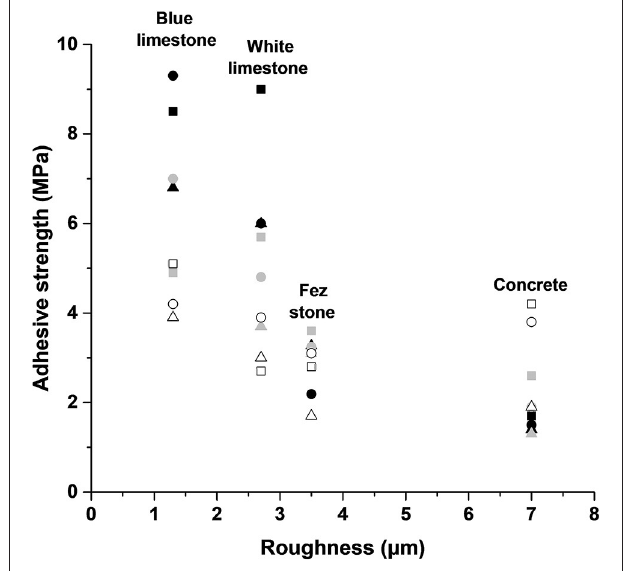
FIGURE 6 | Adhesive strength of the coatings S1M1 ( (cid:4) ), S1A3 ( N ), and S1A5 ( (cid:8) ) as function of the support’s roughness, with (Black = 50% RH), (Gray = 85% RH), and (White = T = − 2.3 to 7.3 ◦ C; and RH =